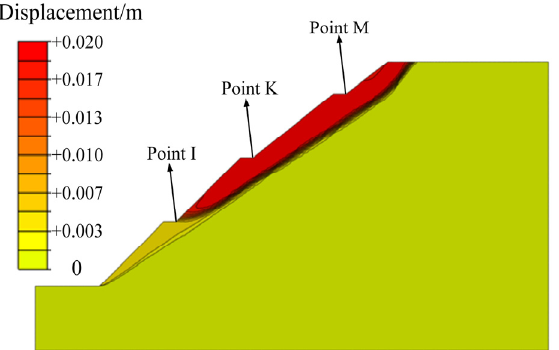
Figure 13. Failure mode of the slope without protection after rainfall infiltration.